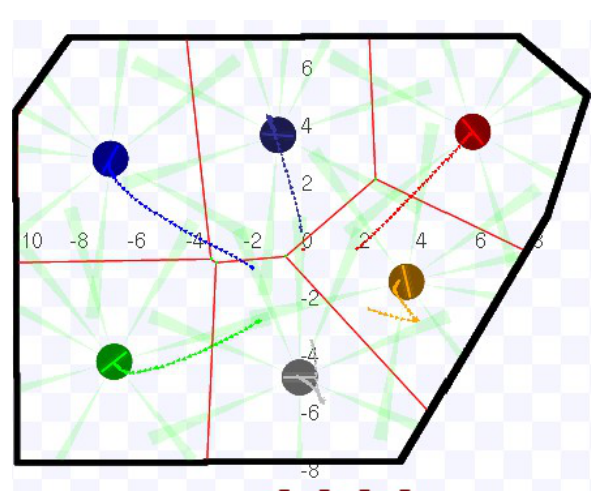
Figure 9: Final configurations for Experiment I.